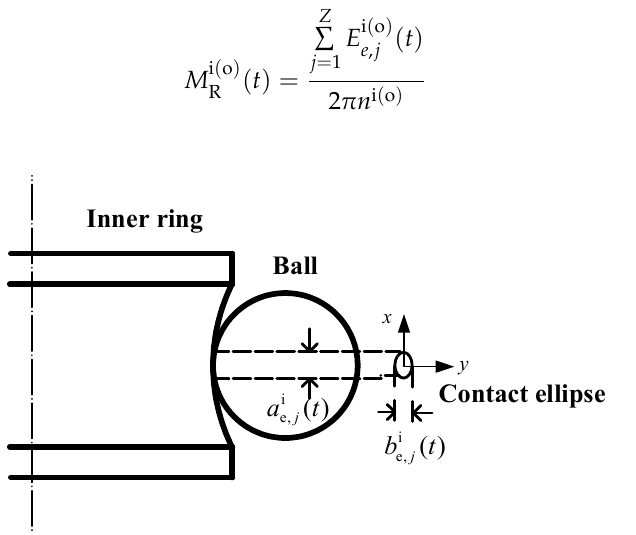
Figure 7. The contact between ball and inner ring of angular contact ball bearing (ACBB).